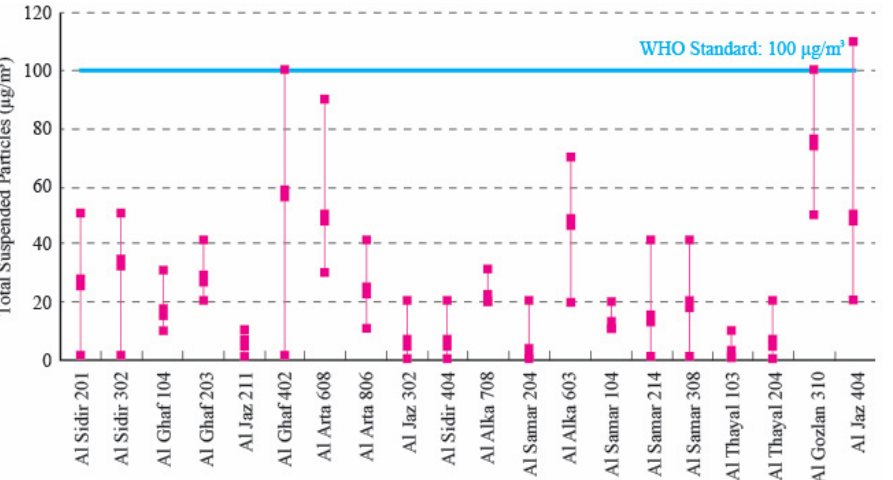
Figure 5. TSP concentrations in 20 housing units at The Greens, Dubai.